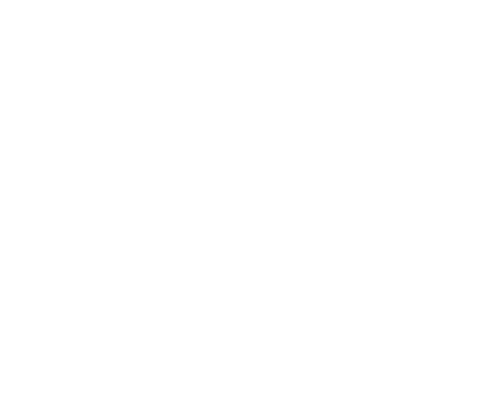
Figure 8. Quasi-periodic masonry, failure multipliers for different q: mean values for right- and left-oriented forces.